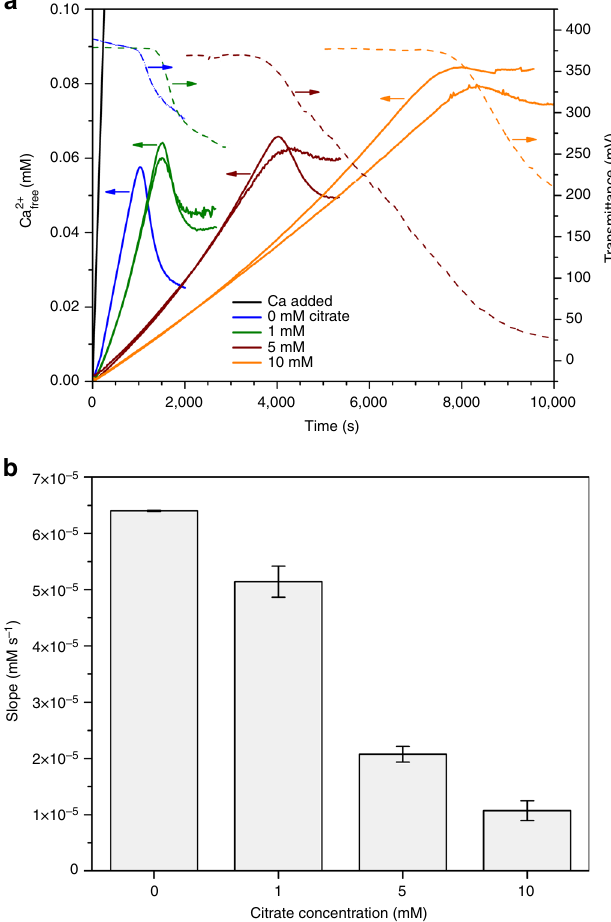
Fig. 1 Results of titration experiments. a Time development of free Ca 2+ concentration in the presence of different amounts of citrate at pH 6.2. Blue lines : control runs; green lines : runs performed in the presence of 1 mM citrate; dark red lines : runs performed in the presence of 5 mM citrate; orange lines : runs performed in the presence of 10 mM citrate. The black line refers to the amount of Ca 2+ added. Evolution of transmittance is also represented ( dotted lines ). Two replicates are presented for each run. b Bar plot illustrating the effect of added citrate on the slope of t -dependent free Ca 2+ concentration prior to nucleation. Error bars show